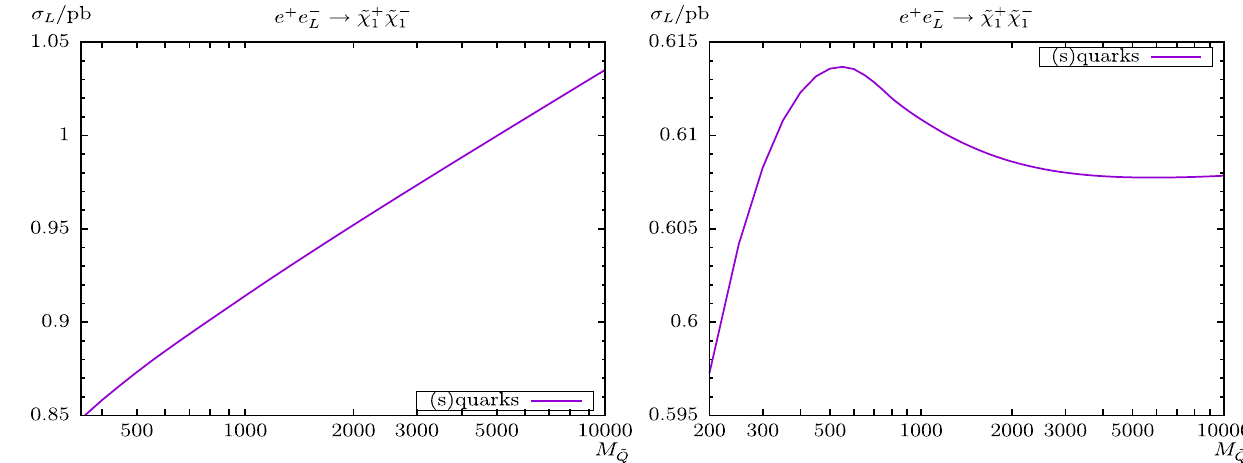
→ ˜ χ + ˜ χ − ) . The left (right) plot shows cross sections with M ˜ L 1 1